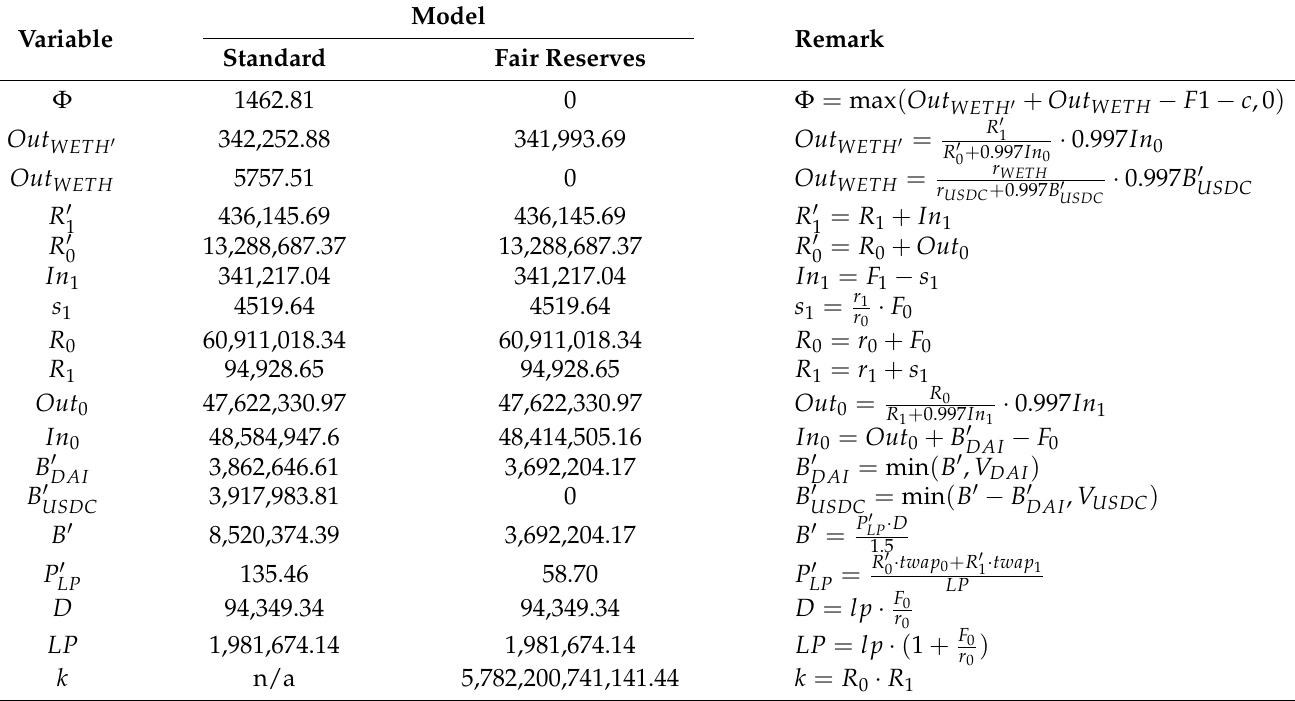
Table 2. Warp Finance damage model